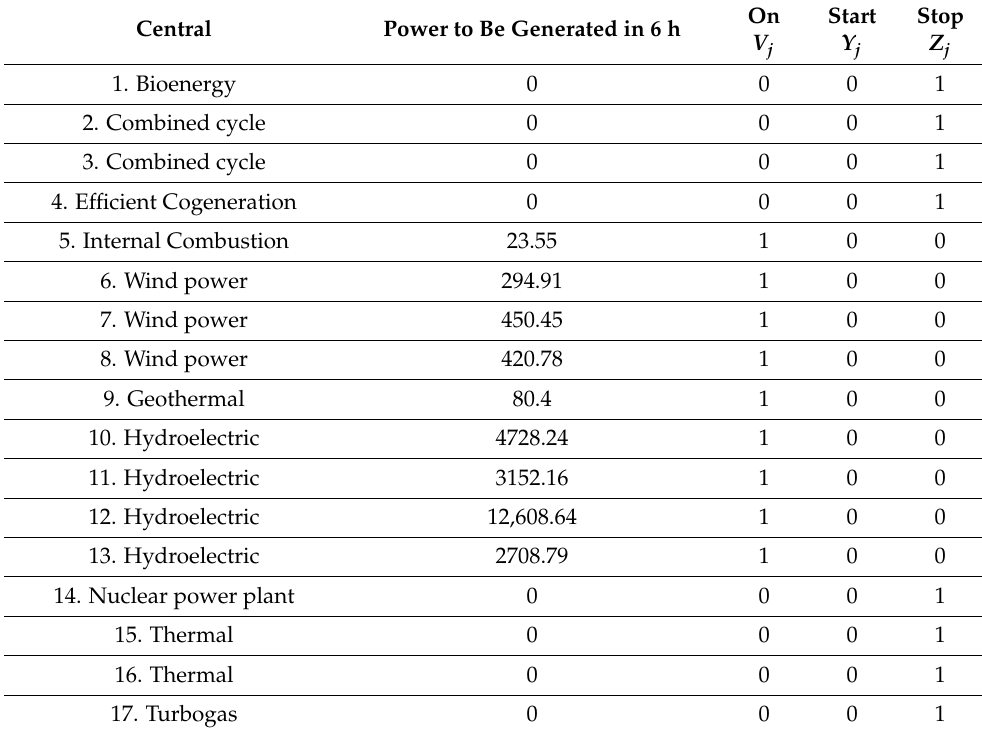
Table 4. Results of Period 2. Central Power to Be Generated in 6 h